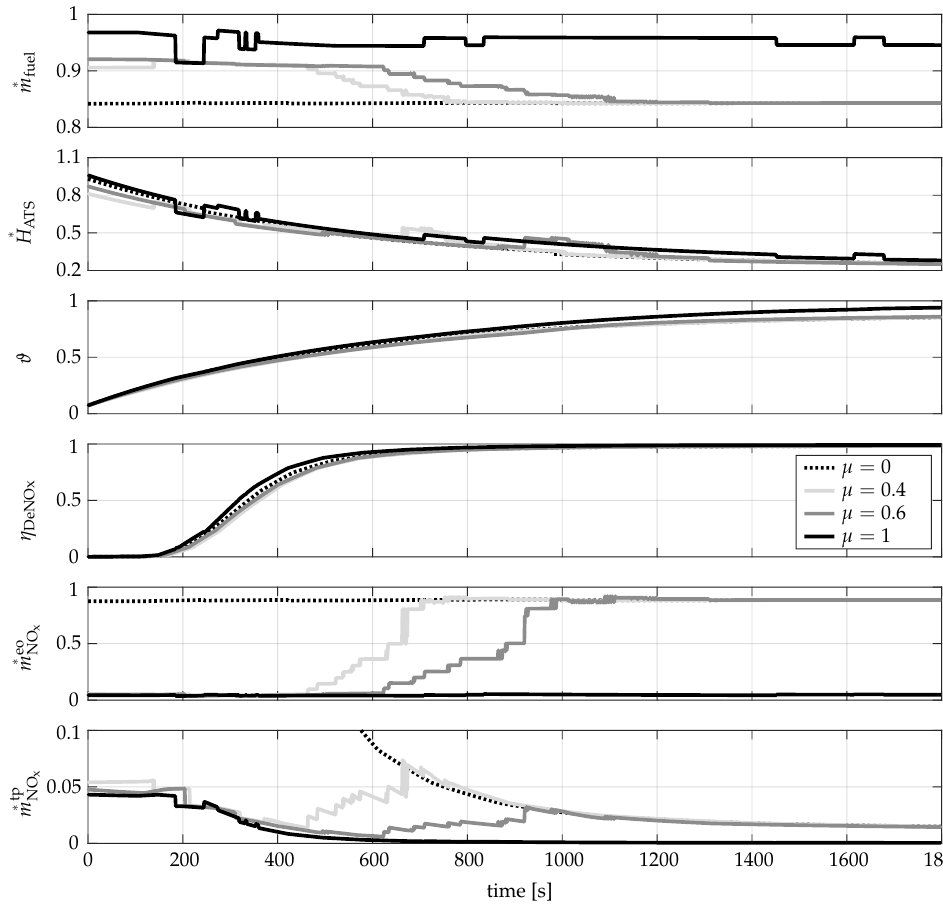
Figure 12. Comparison of the operation of the Conv VEC case at different NO x optimization weights µ for the simplified driving mission. All values were